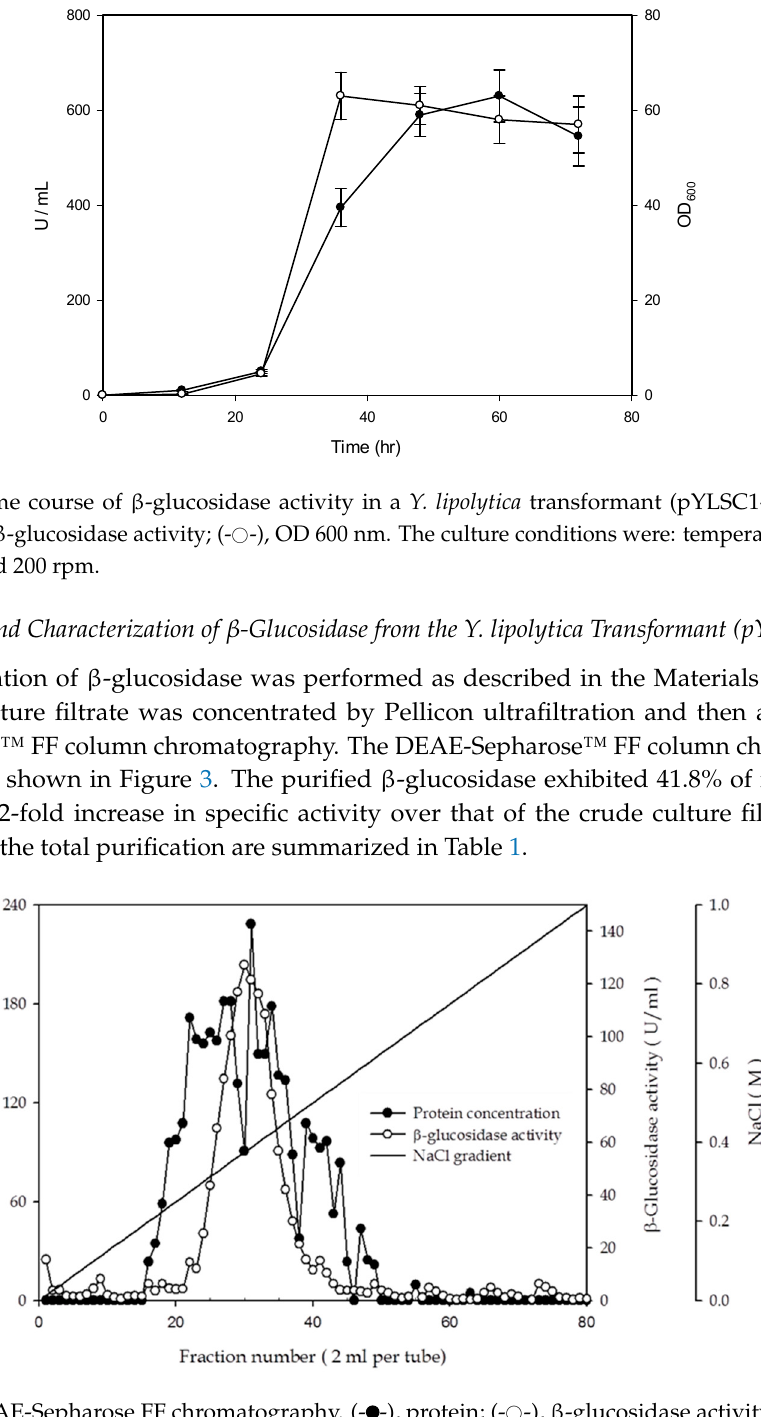
-), β -glucosidase activity; (-) NaCl (cid:35)